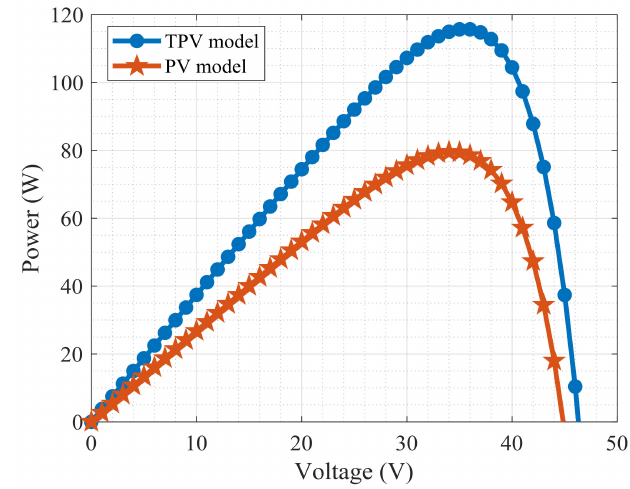
Figure 2. Photovoltaic Modelling and Simulation Codes predicted power: voltage curves for PV and TPV models.